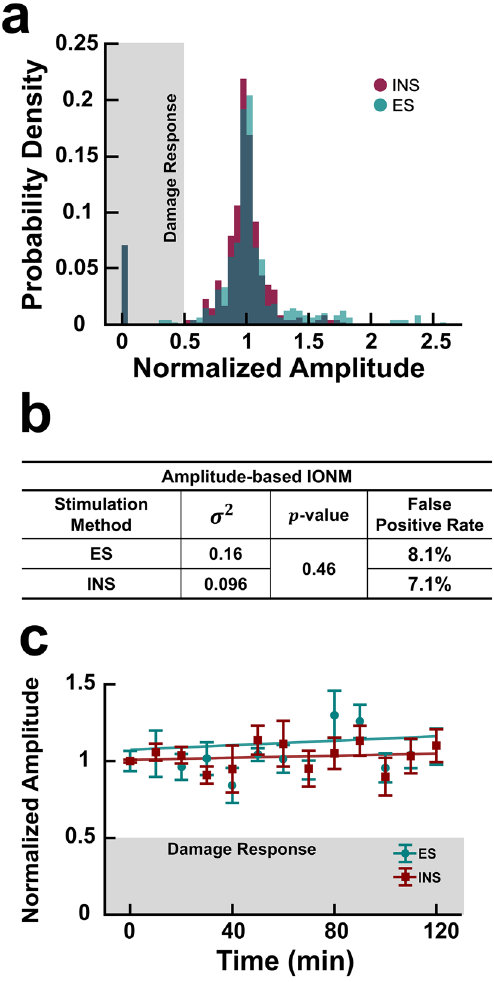
Figure 6. Electrical and infrared neural stimulation evoke consistent amplitudes over time as measured by clinical IONM system. ( a ) Probability distribution of normalized amplitudes evoked in undamaged nerves resulting from ES (teal) and INS (red) using a clinical IONM system. Grayed region represents amplitude values that fall below the damage threshold (50% decrease in amplitude). ( b ) Statistical analysis of amplitude variance and false positive rates. ( c ) Time course of normalized amplitude values over two hours produced by ES and INS. All values normalized to the mean at t = 0 min . Linear fitting performed on all data for ES ( R 2 = 0.026 and INS ( R ). n = 12 nerves for all distribution graphs [ a – b ; 6 rats total]; n = 3 nerves and rats for time course plot in ( c